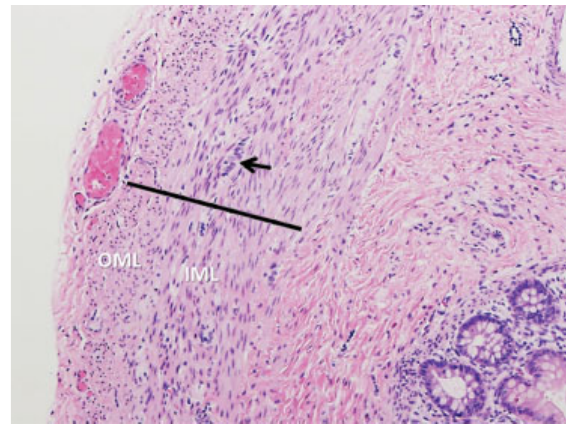
Fig. 4 H&E stain ( (cid:1) 100). Appendix of a 4-day-old infant with total colonic Hirschsprung disease (HD). Despite absence ofganglion cells in the entire colon, there were ganglion cells in the submucosa of the appendix as shown by the arrows. The muscularis propria is indicated by the solid line. IML, inner muscular layer; OML, outer muscular layer.